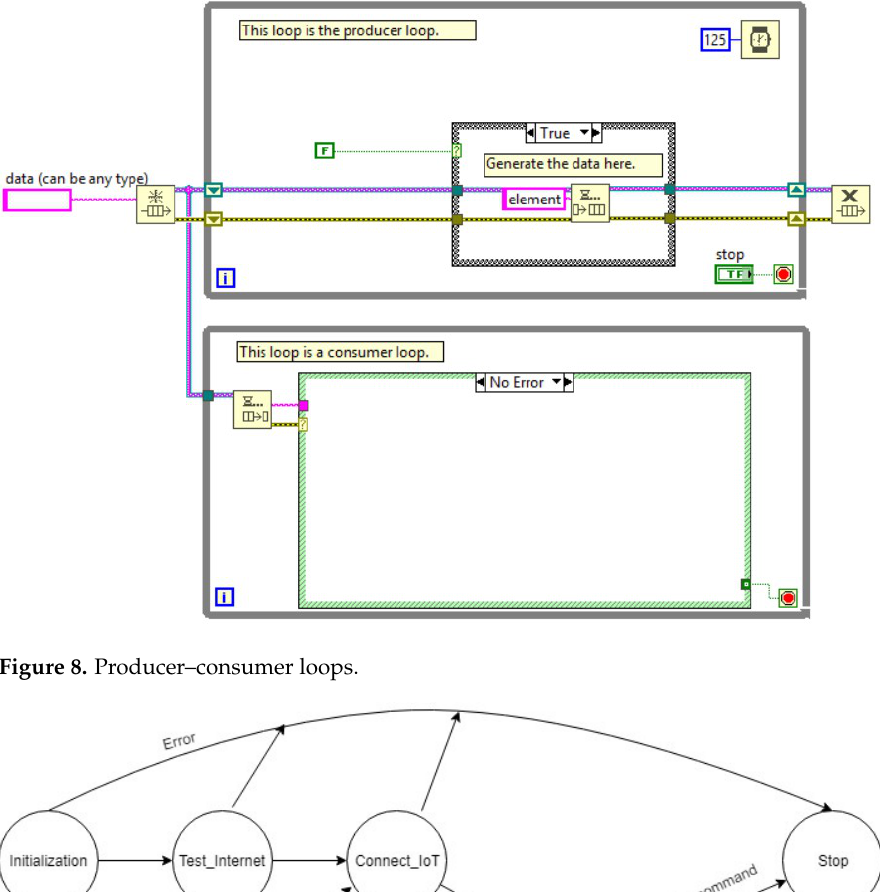
Figure 8. Producer–consumer loops.